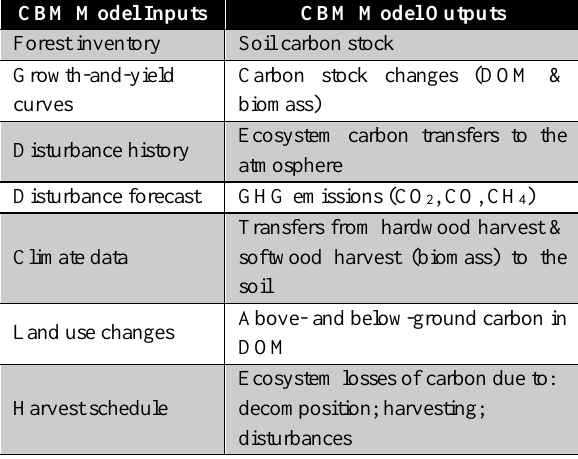
Table 1. Sampling of inputs and outputs from CBM